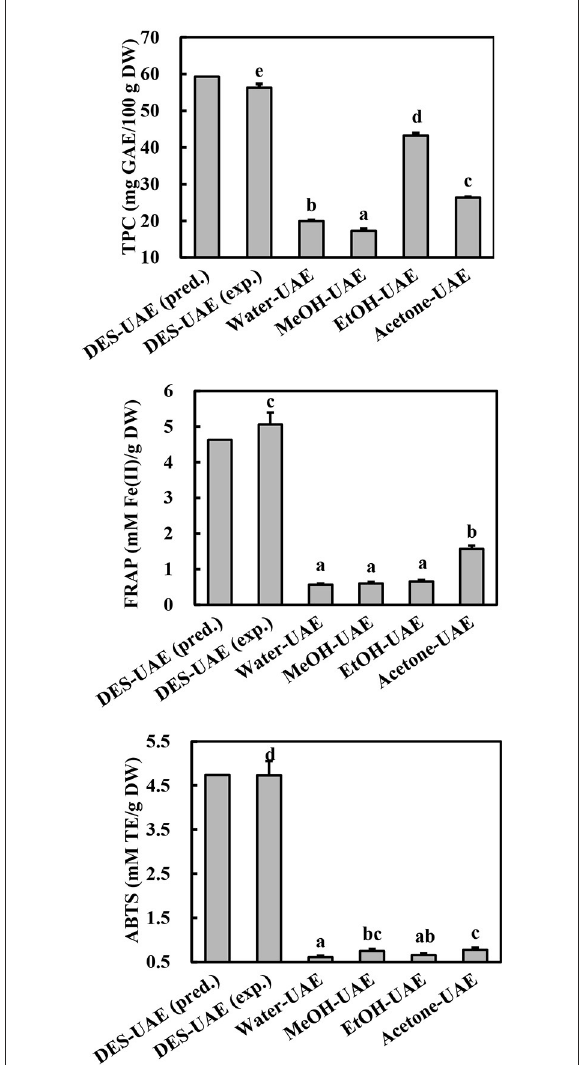
FIGURE4 TPC and antioxidant ability of Asparagopsis taxiformis extracts gained by DES-UAE and UAE with traditional solvents. Different letters indicated significant differences ( p < 0.05). DES-UAE, Water-UAE, MeOH-UAE, EtOH-UAE, Acetone-UAE: ultrasound-assisted extraction with deep eutectic solvent (Bet-Lev), water, 70% methanol, 70% ethanol and 70% acetone, respectively. exp.: experimental value; pred.: predicted